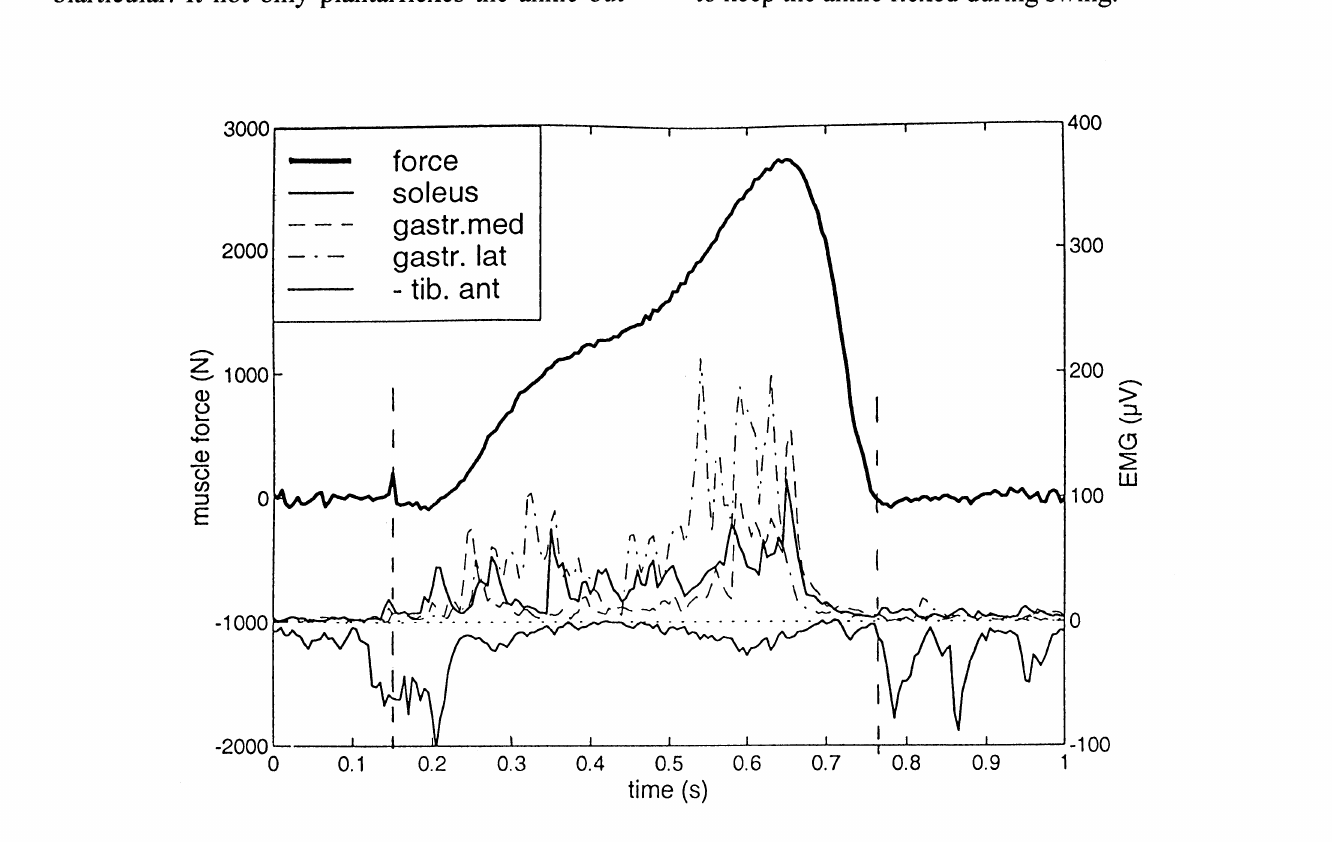
Force and EMGs of the human plantarflexor muscles during walking at normal speed. Stance period is between the vertical dashed lines. During stance, the major plantarflexors, soleus and both heads of gastrocnemius, all are active. Dorsiflexor tibialis anterior (EMG drawn downward) is active in swing to keep the tbot from the ground. There is a short period of co- contraction at the transition from swing to